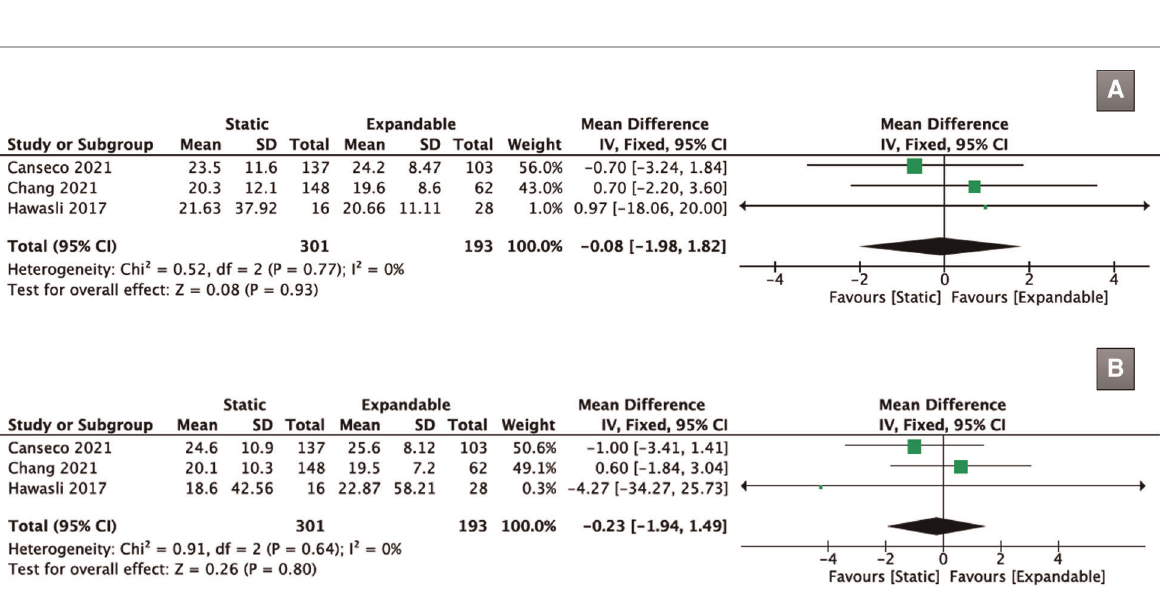
the mean VAS score for back pain in the expandable group decreased from 6.5 preoperatively to 2.9 at the fi nal follow-up. Four studies ( n = 519) provided data on VAS scores for leg pain. Although the preoperative VAS score for leg pain was